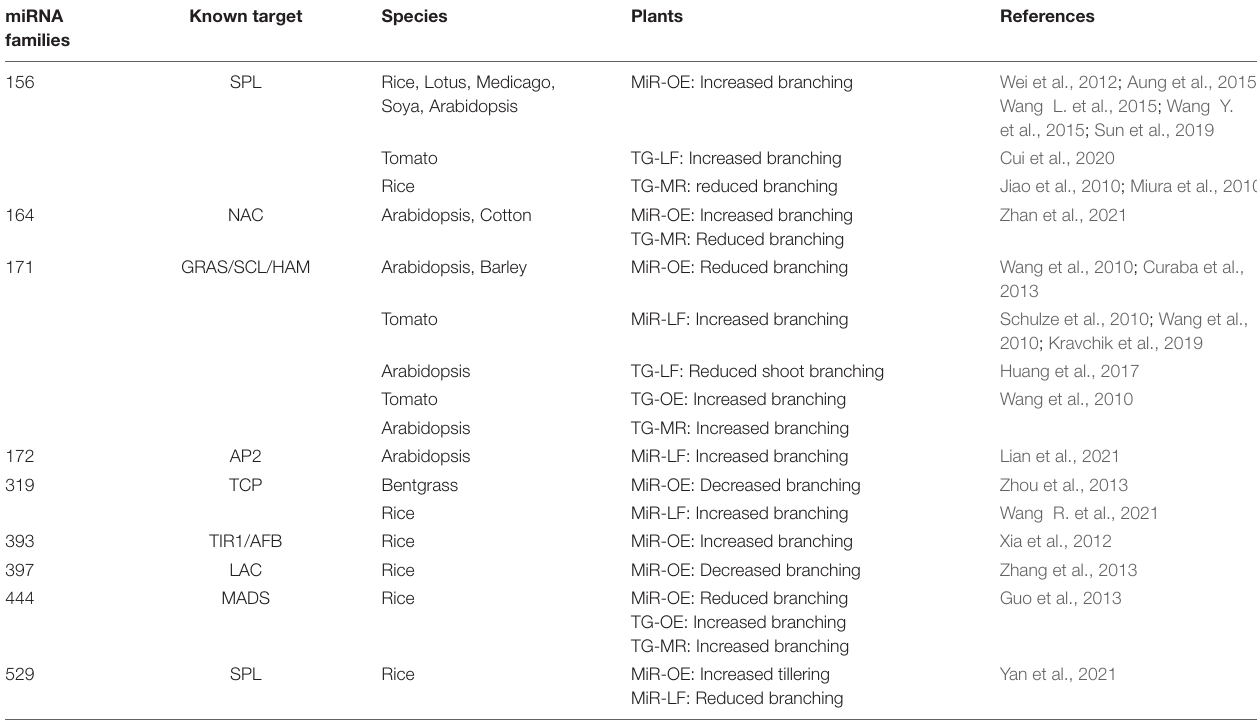
TABLE 1 | Main conserved miRNA families and their associated targets causing shoot branching modulation. miRNA